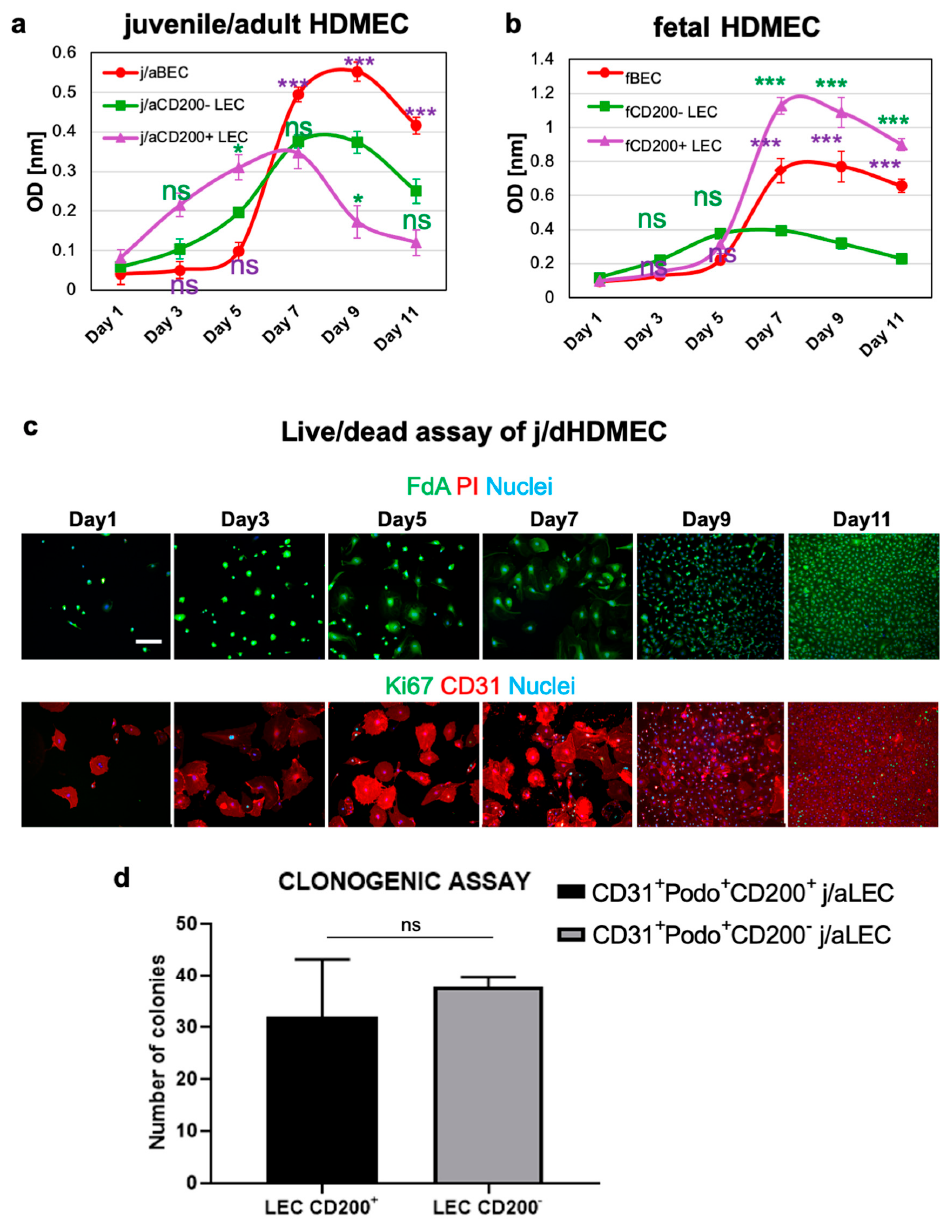
Figure 3. Proliferation rate of juvenille/adult (j/a) and fetal (f) CD200 +/ − LEC and BEC in vitro. ( a ) Graphical representation of proliferation rates of CD200 + and CD200 − BEC and LEC isolated from j/a skin samples. Cells were plated at a concentration of 5 × 10 3 cells per well (6-well plate), and their numbers were determined up to 11 days after plating by colorimetric cell counting assay. J/aCD200 + LEC (violet line) showed a higher proliferation rate in the first 5 days of the measurement as com- pared to j/aCD200 - LEC (green line) and j/aBEC (red line). In turn, from day 7–11 during the assay,